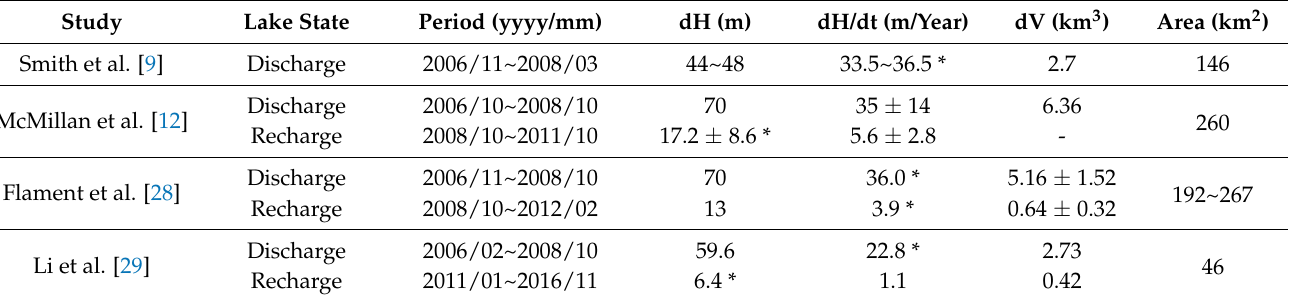
Figure 2. Time series of elevation changes using altimeter data. ICESat and CryoSat-2 data were used in previous studies (reproduced after [9,12,28,29]) while ICESat-2 data were added in this study. Table 1. Results of previous studies [9,12,28,29].